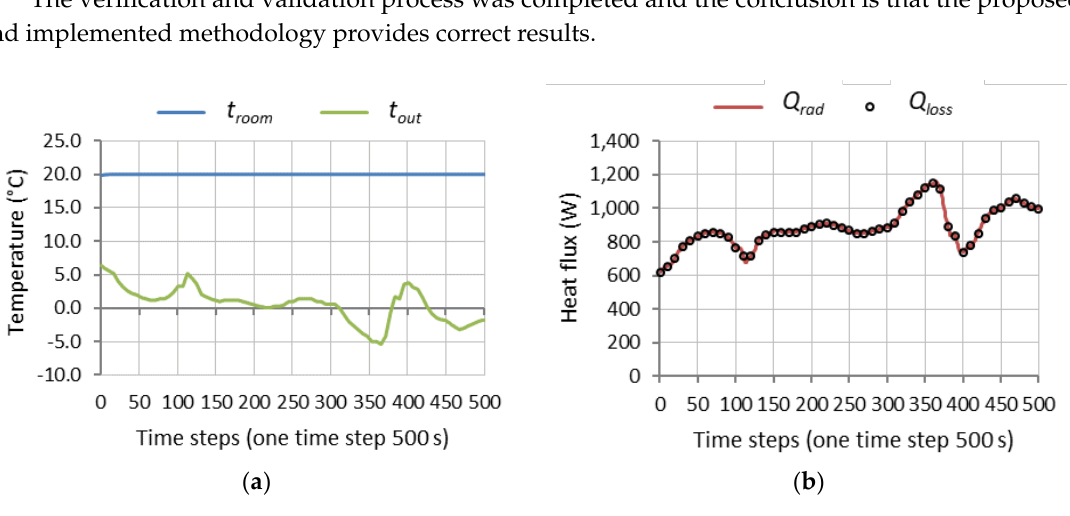
Figure 9. ( a ) Room and variable outside temperature; ( b ) Comparison of radiator flux versus total heat losses.